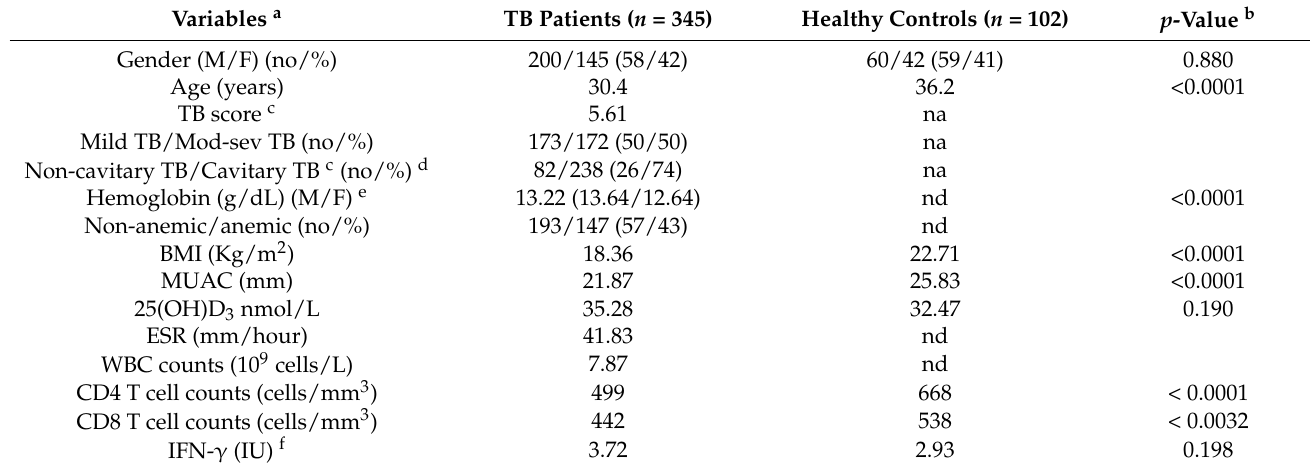
Table 1. Baseline characteristics in pulmonary TB patients and healthy